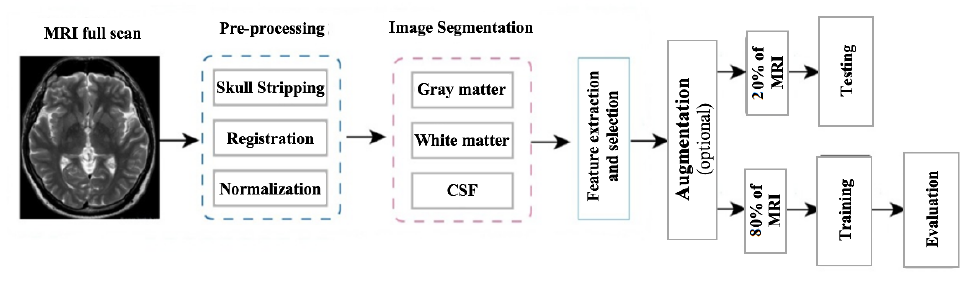
Figure 12. Framework of the proposed methodology.